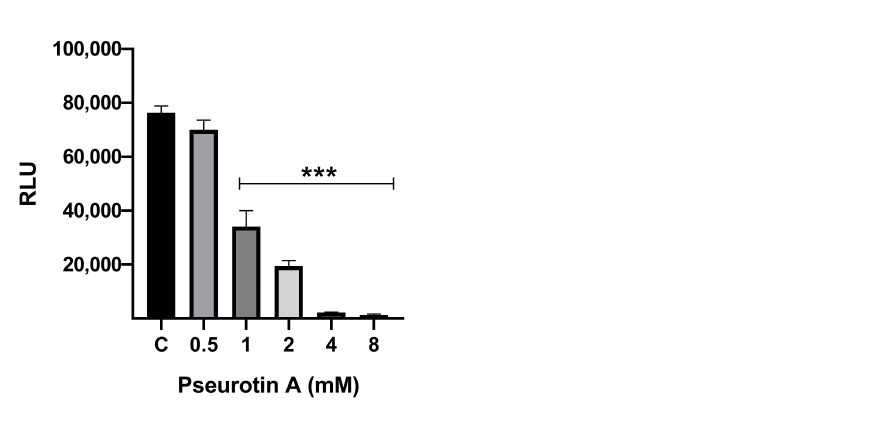
Figure 3. Effect of PsA treatments on the intracellular ATP levels of RWPE-1 cells. Bar graph shows the dose response of mitochondrial functionality of PsA after 24 h treatment. Data shown as mean ± SEM of triplicate wells. *** indicates a statistical significance at p < 0.001. 2.1.3. The Effect of PsA on the Apoptotic Signaling Pathway in Human Normal Prostatic RWPE-1 Cells Treatment of the RWPE-1 normal human cells with PsA at 1 and 2 mM for 24 h induced a significant downregulation of the antiapoptotic Bcl-2 protein (Figure 4). For instance, 1 mM PsA decreased the expression level of Bcl-2 by more than two-fold, while 2 mM reduced Bcl-2 expression by five-fold when compared to untreated control cells. Furthermore, PsA treatments induced the expression levels of the pro-apoptotic Bax in a dose-dependent manner (Figure 4). For example, 1 mM PsA upregulated the Bax expression level by 42%, while 2 mM induced Bax expression by more than 100% (Figure 4) in comparison to Bax level in the untreated control cells. Moreover, proteolytic caspases 3 and 7 were upregulated upon treatment with PsA in a concentration-dependent manner (Figure 4). The expression level of cleaved caspase-3 was increased by 1.5-fold and 4-fold in response to treatments by 1 and 2 mM PsA, respectively (Figure 4). Meanwhile, the expression level of cleaved caspase-7 was doubled in response to PsA treatment at 1 mM and quadrupled at 2 mM concentration (Figure 4).